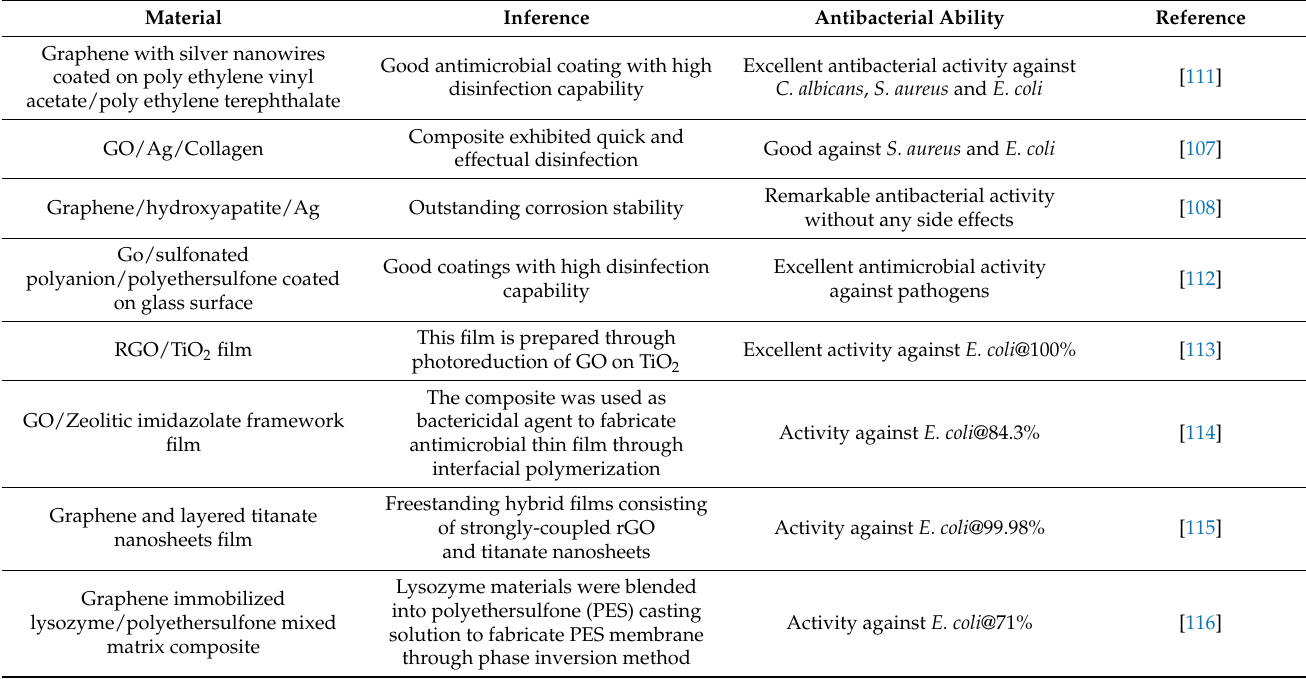
Table 4. Examples of graphene-based antimicrobial films and